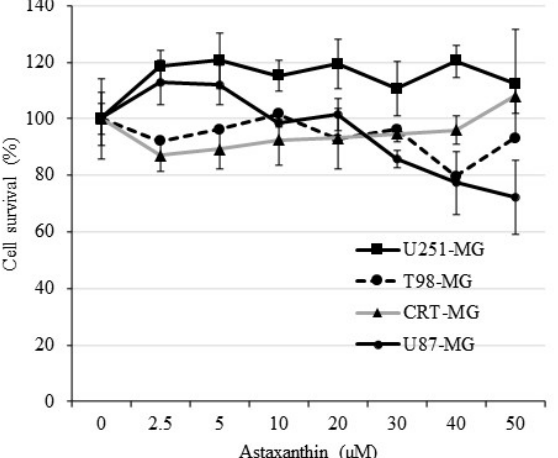
Figure 1. AXT treatment to GBM cells does not affect cell viability. The U251-MG, T98-MG, U87-MG, and CRT-MG were seeded in 96-well plates and treated for 24 h with AXT at concentration from 0 to 50 µ M in serum-free media. Cell survivals are expressed in %, compared to 0.1% DMSO-treated control as 100%. Results are shown as average with SD.